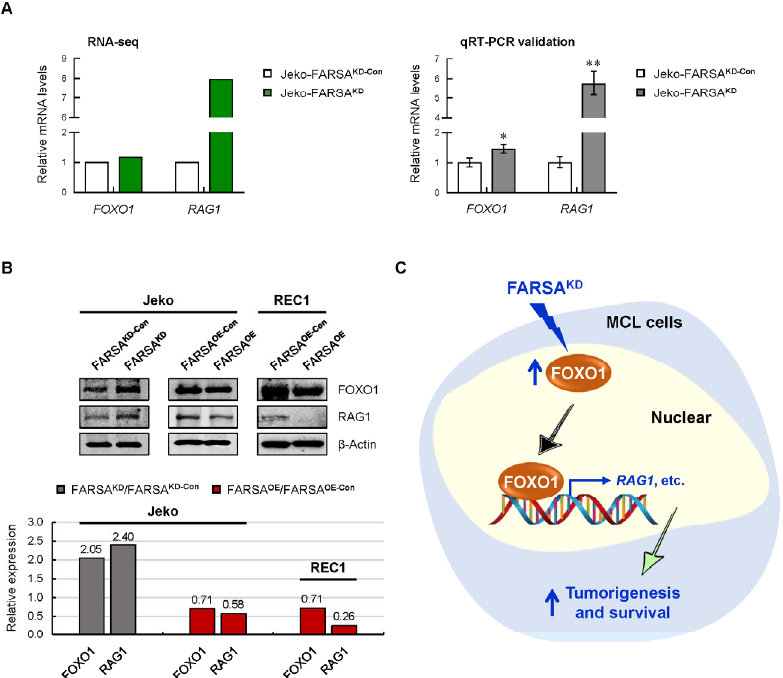
Figure 7. FARSA-mediated activation of the FOXO1-RAG1 signaling in MCL cells. ( A ) Relative mRNA levels of FOXO1 and recombination activating 1 ( RAG1 ) from the RNA-seq ( left ) and qRT- PCR ( right ). Each value from the RNA-seq in FARSA KD Jeko cells was relative to the control cells. Each value from qRT-PCR was normalized to ACTB and is presented as the mean ± SD. * p < 0.05; ** p < 0.01 (vs. control group). ( B ) Immunoblots of FOXO1 and RAG1 in FARSA KD Jeko, FARSA OE Jeko and FARSA OE REC1 cells ( upper ). β -Actin was used as a loading control. The expression of each protein was normalized to the corresponding β -Actin, and the relative expression of each protein in FARSA KD or FARSA OE cells is indicated relative to the control cells ( lower ). ( C ) FARSA knockdown